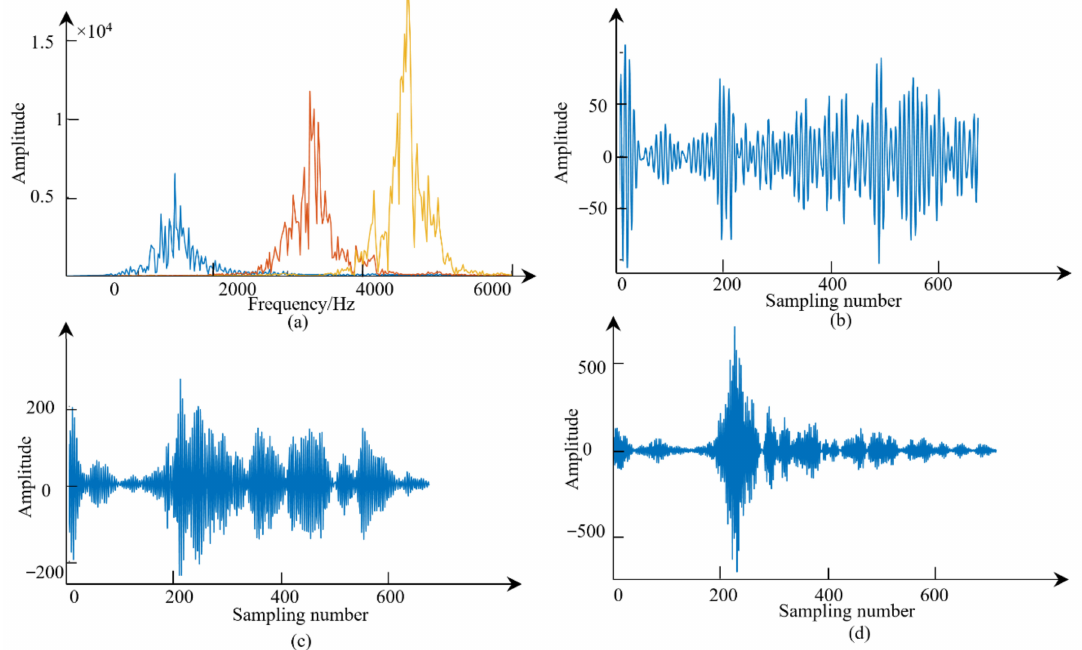
Figure 5. Illustration of the MVMD result. ( a ) The spectral ratio of the decomposed modes of one ping. ( b ) The first mode after decomposition. ( c ) The second mode after decomposition. ( d ) The third mode after decomposition. WVD shows the time–frequency distribution of the input signal. At every sampling time, a set of frequencies can be obtained. Thus, WVD has high time and frequency resolution. The WVD of one mode is shown in Figure